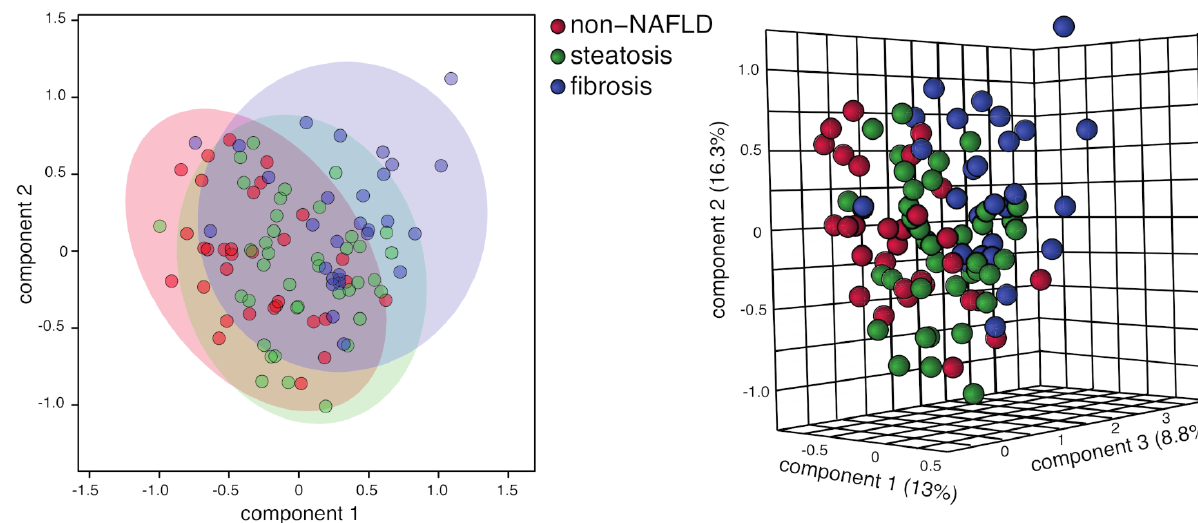
Figure 5. Log normalized PLS-DA clustering of all three groups (performed with Metaboanalyst [46]). Comparable results are similar for different normalizations schemes and also when excluding lactate and glucose. Significant variables (VIP > 1.2) are 2-hydroxyisovalete (3.5), acetone (3.2), 3-hydroxybutyrate (2.1), pyruvate (1.6), and azelate (1.3). Note that in the right-hand panel, relatively clear separation between fibrosis and non-NAFLD groups is demonstrated with PC1 and PC3 (i.e., the right panel shows a rotation around the PC2 axis relative to the projection in the left